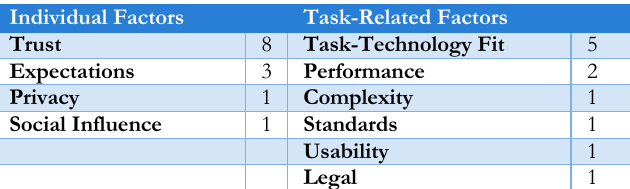
Table 3. Summary of Individual and Task Adoption Factors